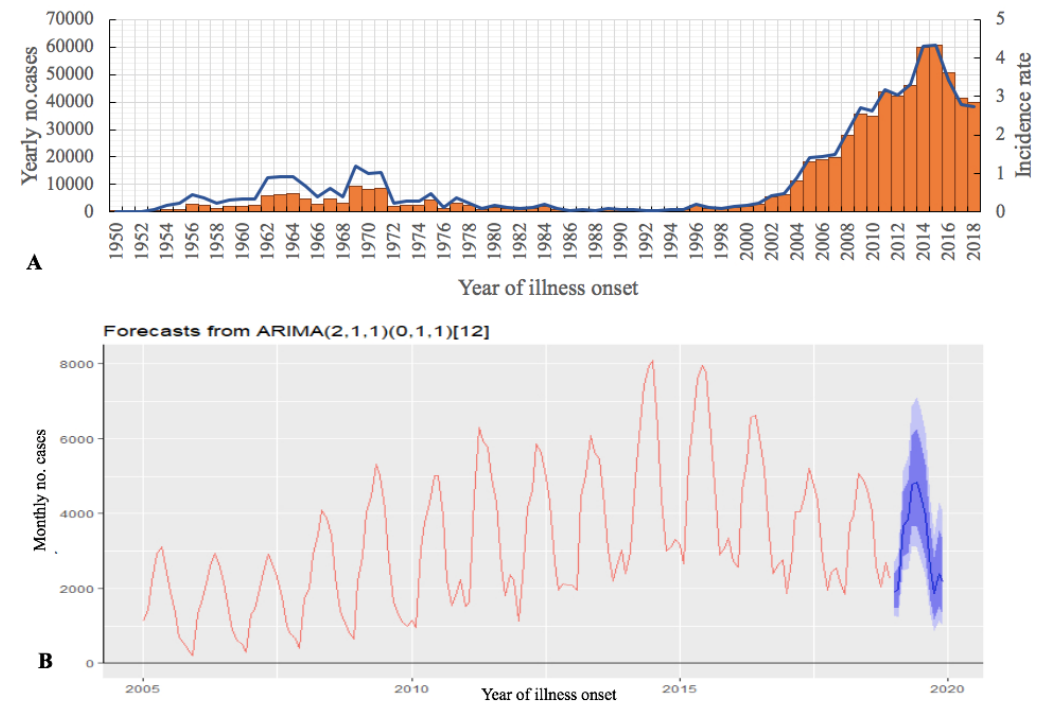
Figure 1. Human brucellosis (HB) cases (N = 684,380), mainland China, 1950 – 2018. ( A ) The number of cases reported by year (orange pillar) and annual incidence (blue line). ( B ) Autoregressive integrated moving average model (ARIMA) used to predict 2019 – 2020 data based on monthly numbers from 2005 to 2018, using 80% CI (light blue) and 95% CI (dark blue) monthly cases (blue